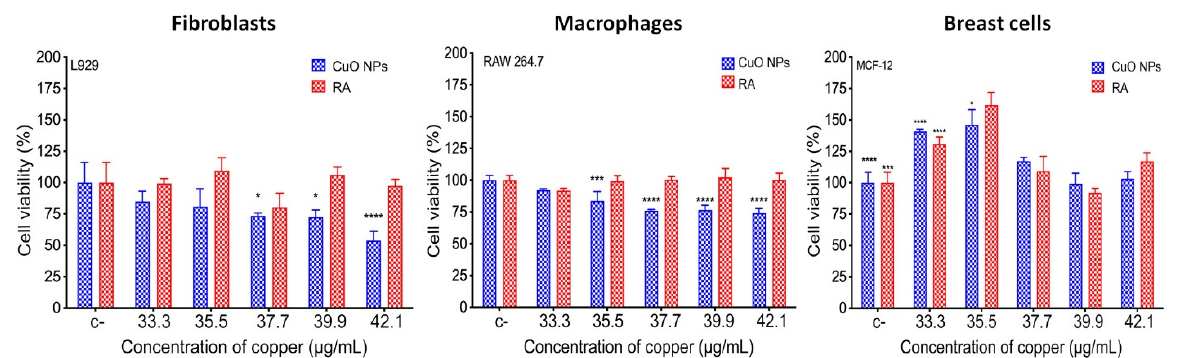
Figure 8. Cell viability assay in fibroblasts (L929), macrophages (RAW 264.7), and breast cells (MCF- 12) exposed to biosynthesized CuONPs. RA = Biological reducing agent, used for the synthesis of CuONPs. The bars represent the mean and standard deviations of experiments performed in triplicate. * p ≤ 0.05, *** p ≤ 0.001, and **** p ≤ 0.0001.